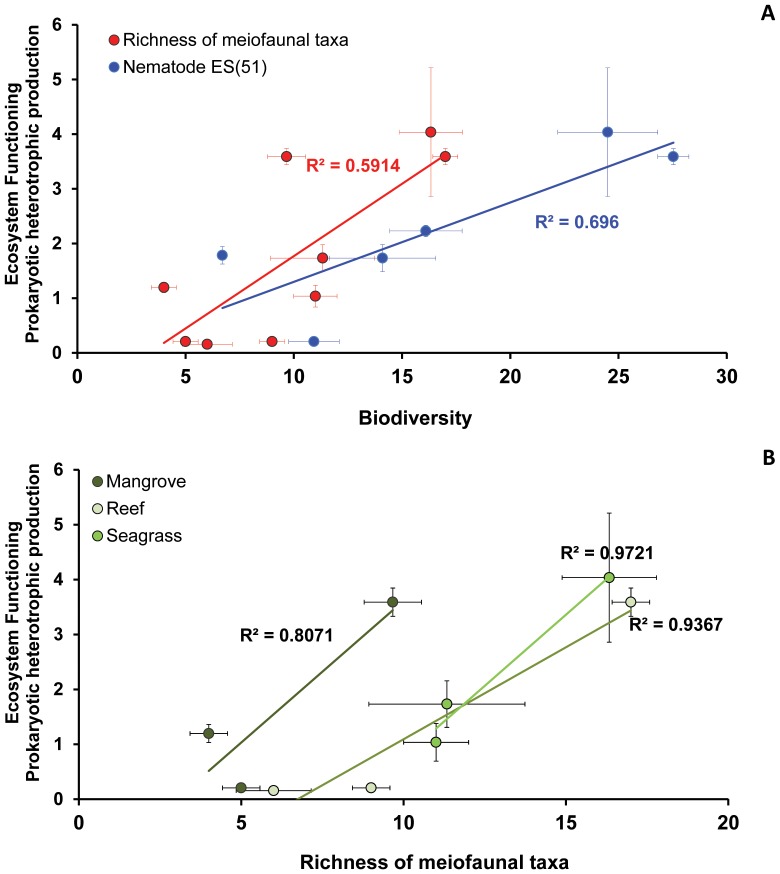
Relationship between biodiversity and ecosystem functioning.Illustrated are the relationships between: A) richness of meiofaunal taxa and prokaryotic heterotrophic production (µgC g−1 d−1); nematode diversity as ES(51) and prokaryotic heterotrophic production (µgC g−1 d−1); B) richness of meiofaunal taxa and prokaryotic heterotrophic production in different habitat types. Reported are R2 values. P<0.01 for all linear regressions. Error bars indicate standard deviations among replicates (n = 3).